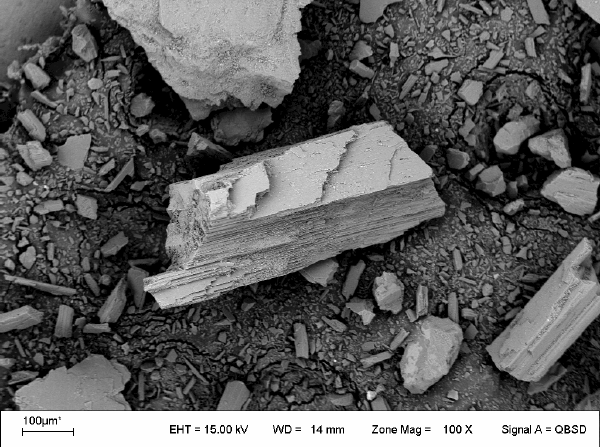
Figure 2. SEM micrograph of the mineral without thermal treatment ( α -spodumene).